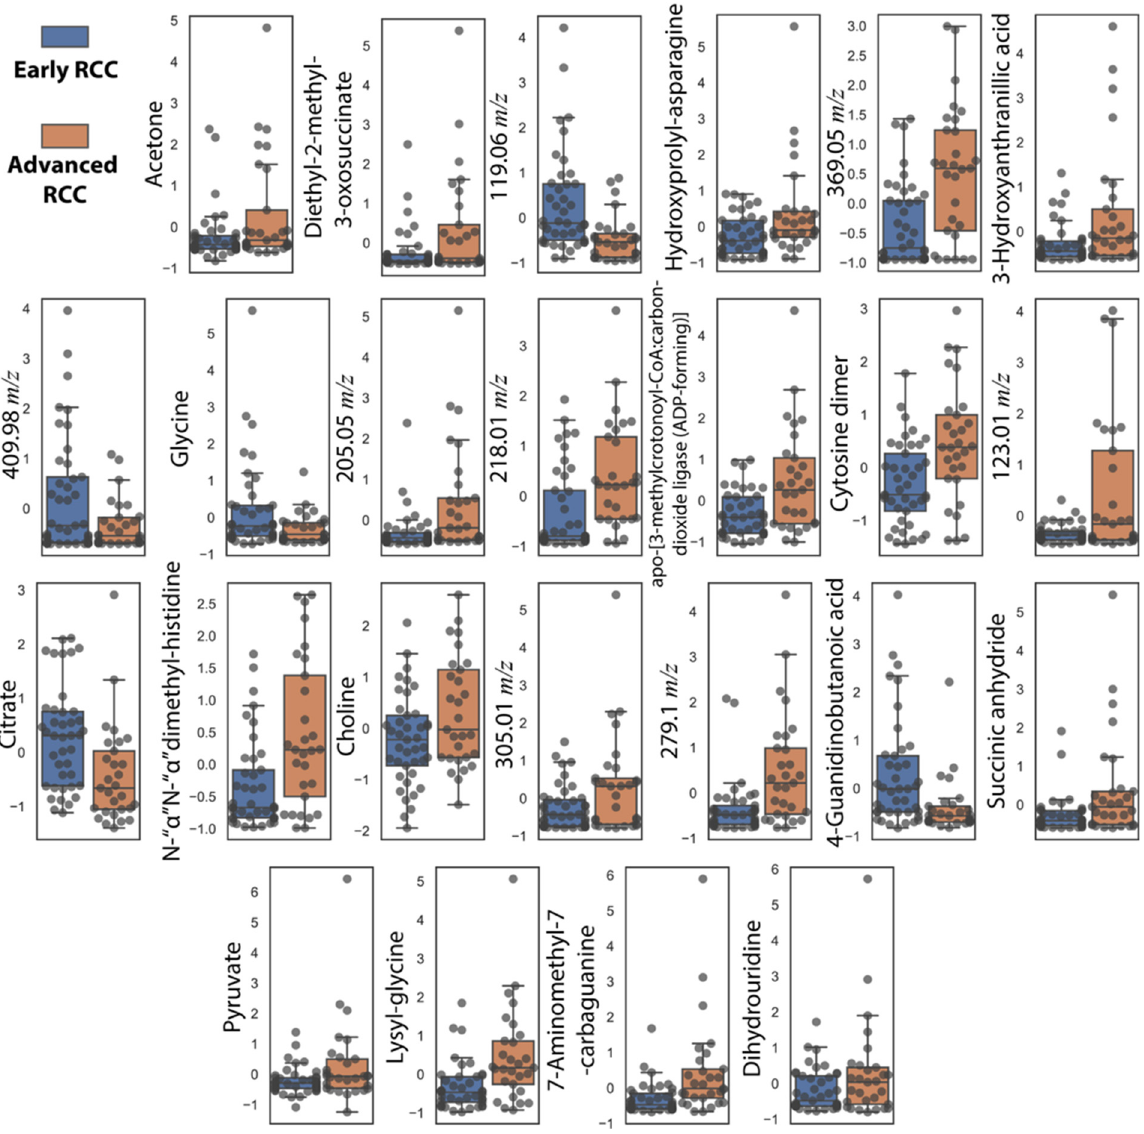
Figure 3. Box plots showing autoscaled normalized relative abundances for the 24 metabolite ‐ panel to distinguish early ‐ stage RCC ( n = 41) from advanced ‐ stage RCC ( n = 29). The mean, upper quartile, lower quartile, minimum, and maximum values are shown. All metabolites had p ‐ values < 0.05 (Student t ‐ test).